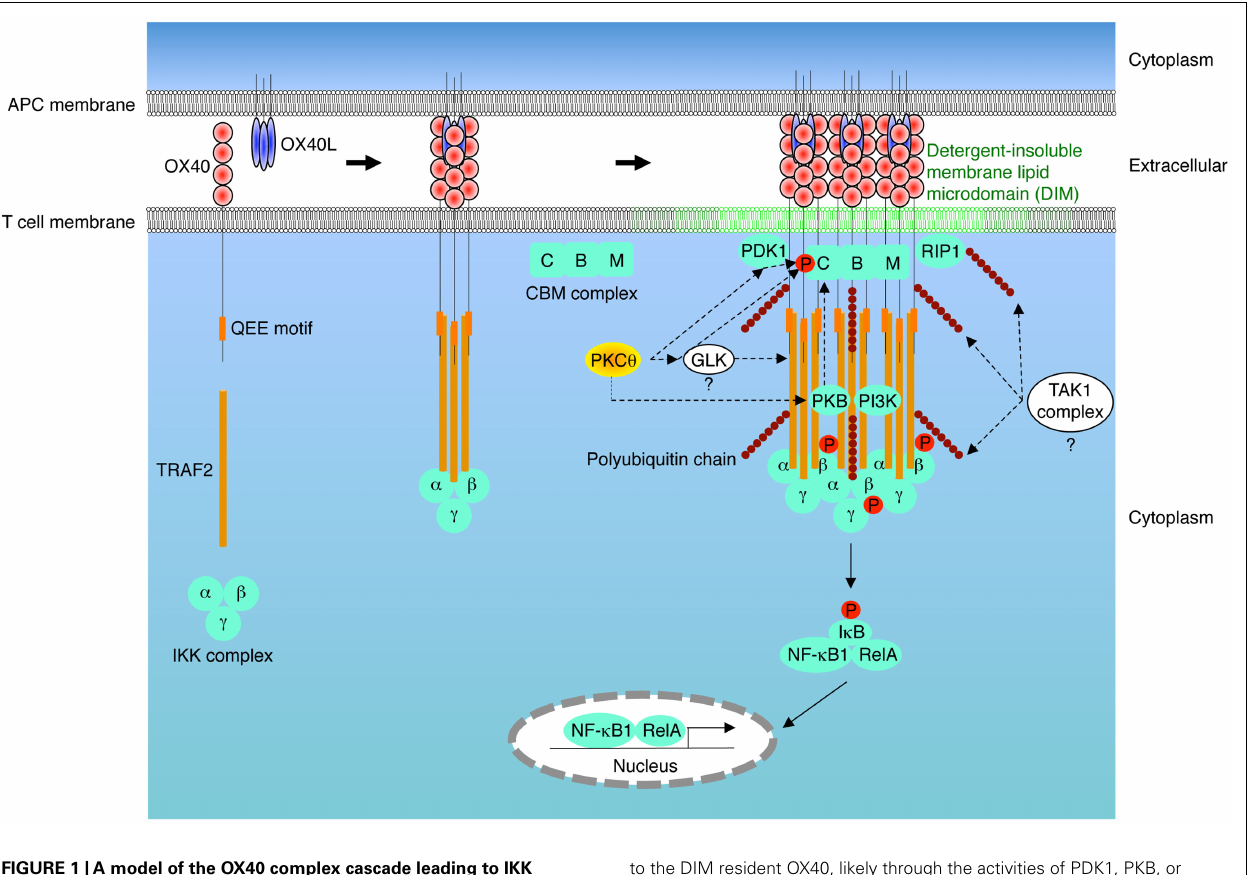
FIGURE 1 |A model of the OX40 complex cascade leading to IKK activation. OX40L binding to OX40 onT cells results in trimerization of OX40 monomers and recruitment ofTNFR-associated factor 2 (TRAF2) to the cytoplasmic QEE motif in OX40.The I κ B kinase (IKK) complex (IKK α , IKK β , and IKK γ ) is then recruited to the OX40-TRAF2 module, but this event is not sufficient for IKK activation.The OX40-OX40L hexamer complex translocates into detergent-insoluble membrane lipid microdomains (DIM).This organizes the higher ordered multimolecular receptor-ligand architecture that is required for IKK activation in aT cell receptor (TCR)-independent manner. Phosphoinositide 3-kinase (PI3K), 3-phosphoinositide-dependent protein kinase-1 (PDK1), and protein kinase B (PKB) are recruited to OX40 in the DIM. Although not yet determined, germinal center kinase-like kinase (GLK) is possibly incorporated into the OX40 signalosome throughTRAF2. Protein kinase C θ (PKC θ ) translocates